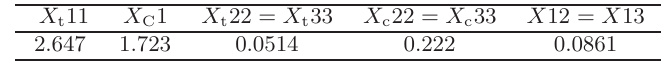
Table 1. Mechanical characteristics of test samples.